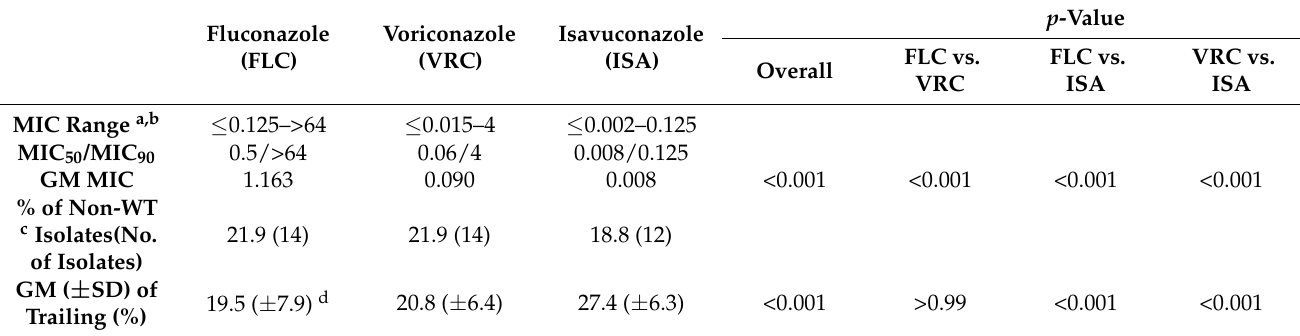
Table 1. Minimum inhibitory concentrations (mg/L), proportions of non-wild-type, and percentage of trailing for different azoles against 64 Candida tropicalis bloodstream isolates.